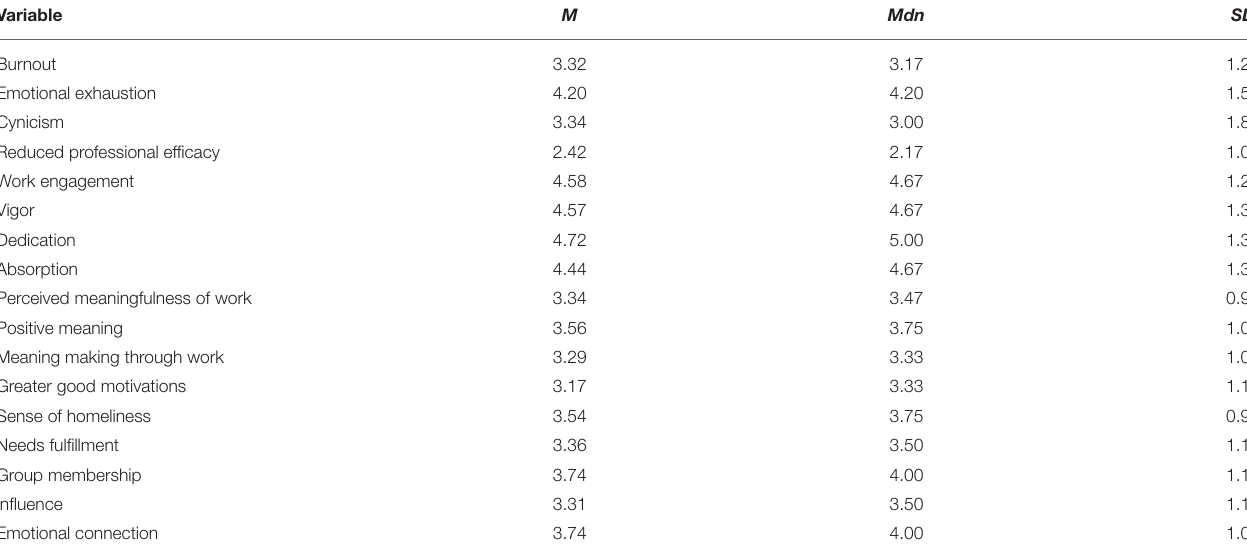
TABLE 2 | Univariate descriptive